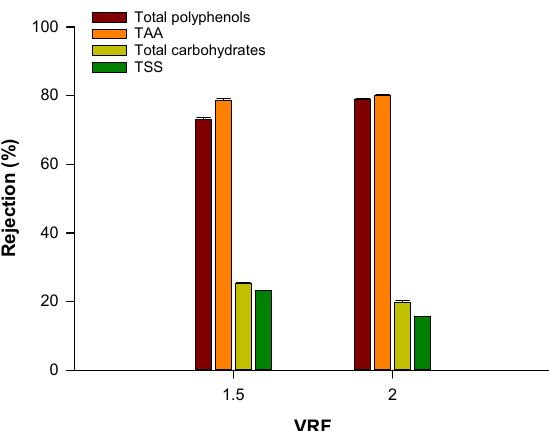
Figure 10. Rejection by the 1 kDa membrane of analyzed compounds as function of the VRF.